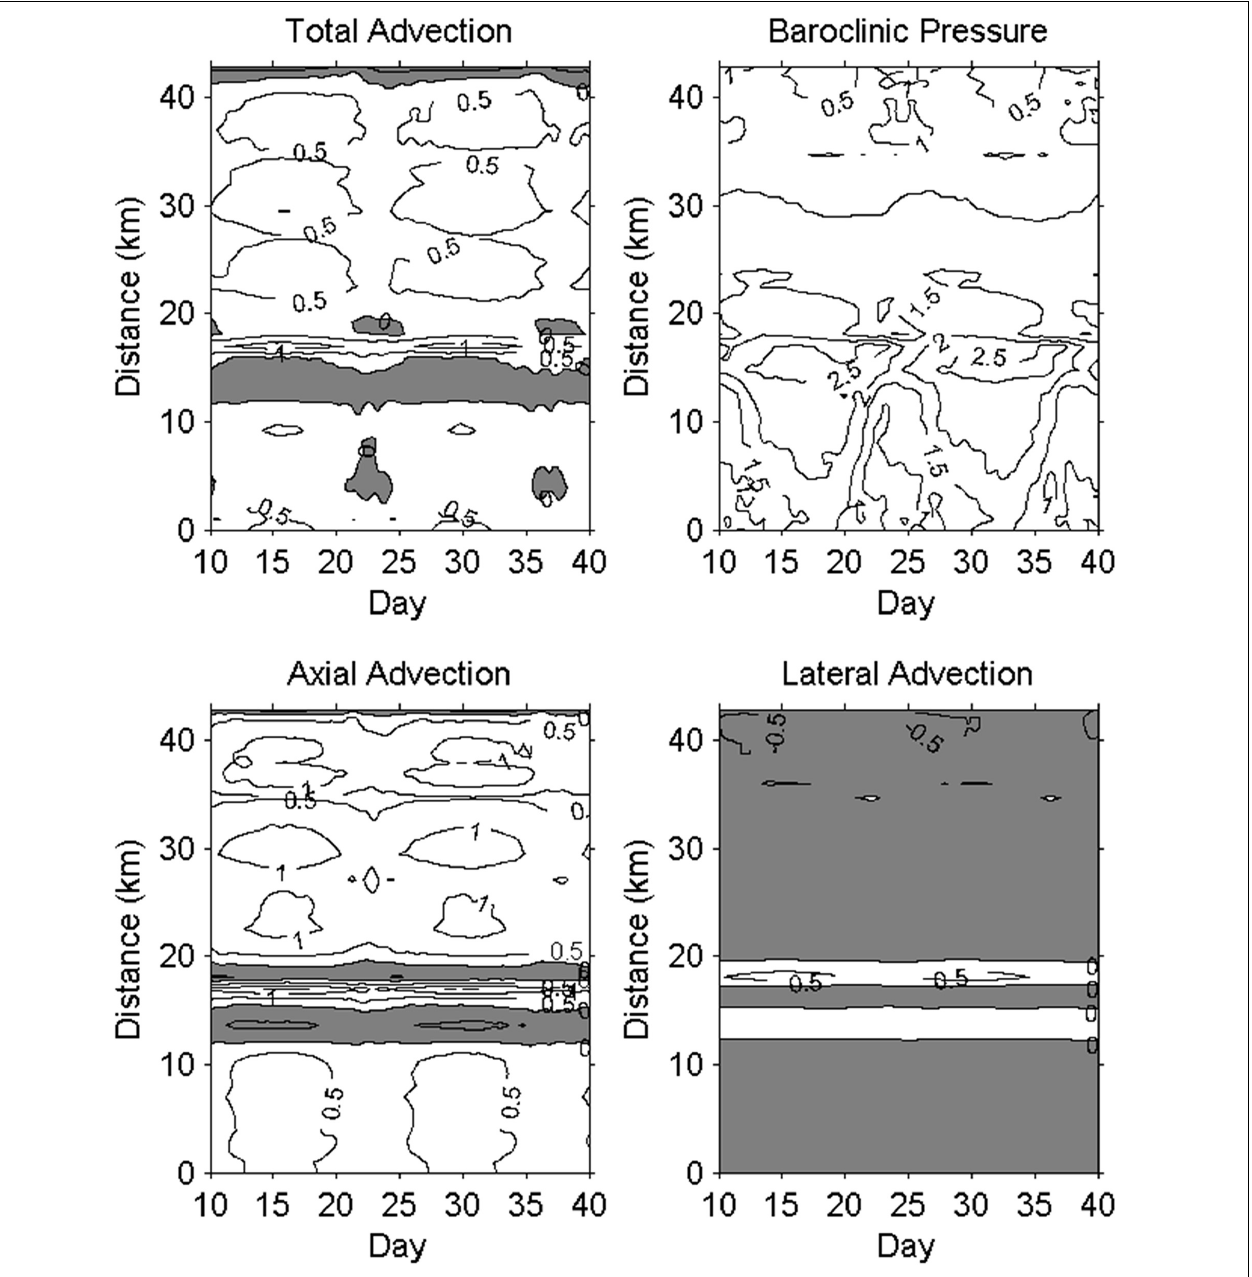
FIGURE 7 | Temporal variations of cross-section averaged subtidal total advection, baroclinic pressure, axial, and lateral advection along the western channel in the PRE ( × 10 − 5 m 2 /s). The y-axis represents the distance from the lower (0 km) to the upper (44 km) PRE.